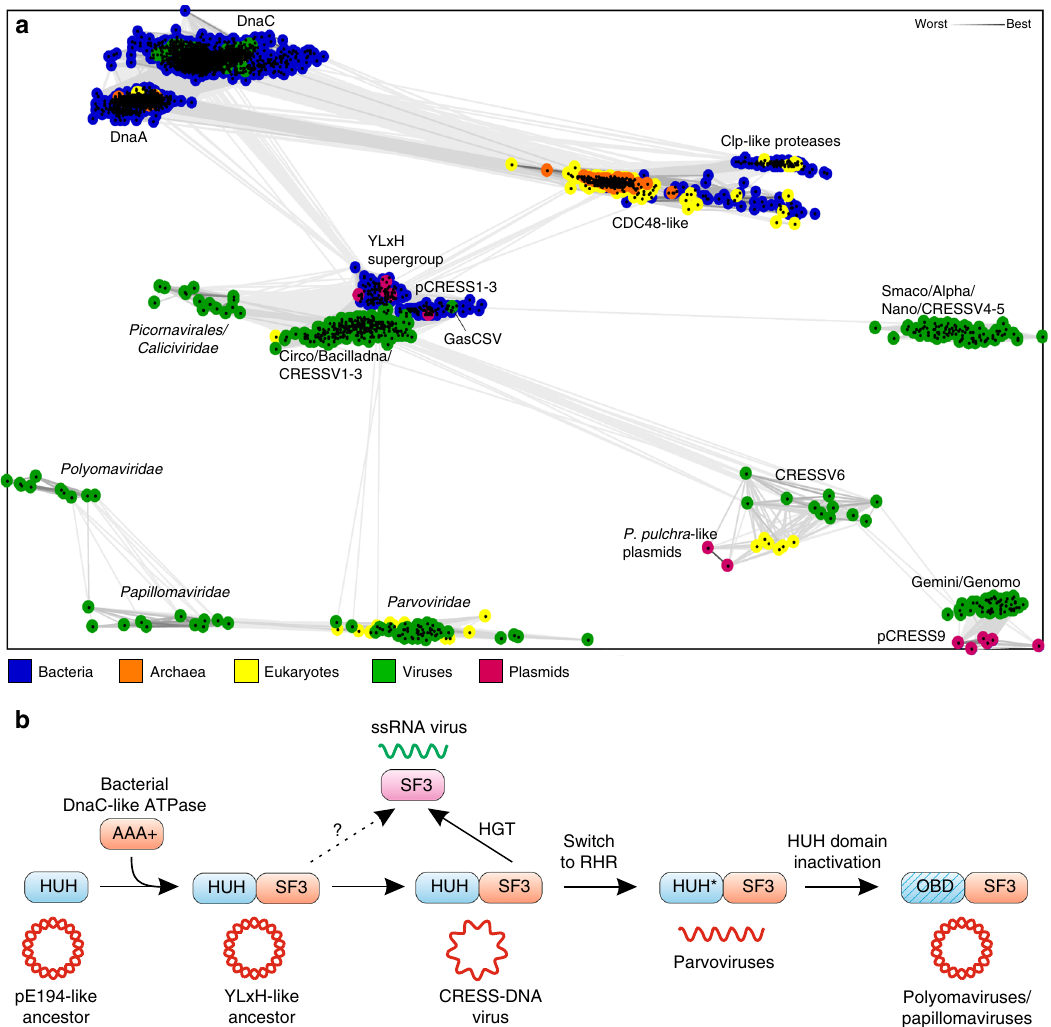
Fig. 4 Relationships between Superfamily 3 helicases and AAA + ATPases. a Superfamily 3 helicase and AAA + ATPase domains clustered by their pairwise similarity using CLANS. In total, 3854 sequences were clustered with CLANS (CLANS P -value ≤ 5e − 09). Groups of unclassi fi ed CRESS-DNA viruses are referred to as CRESSV1 through CRESSV6 (ref. 53 ). b A proposed evolutionary scenario for the origin and evolution of viral Superfamily